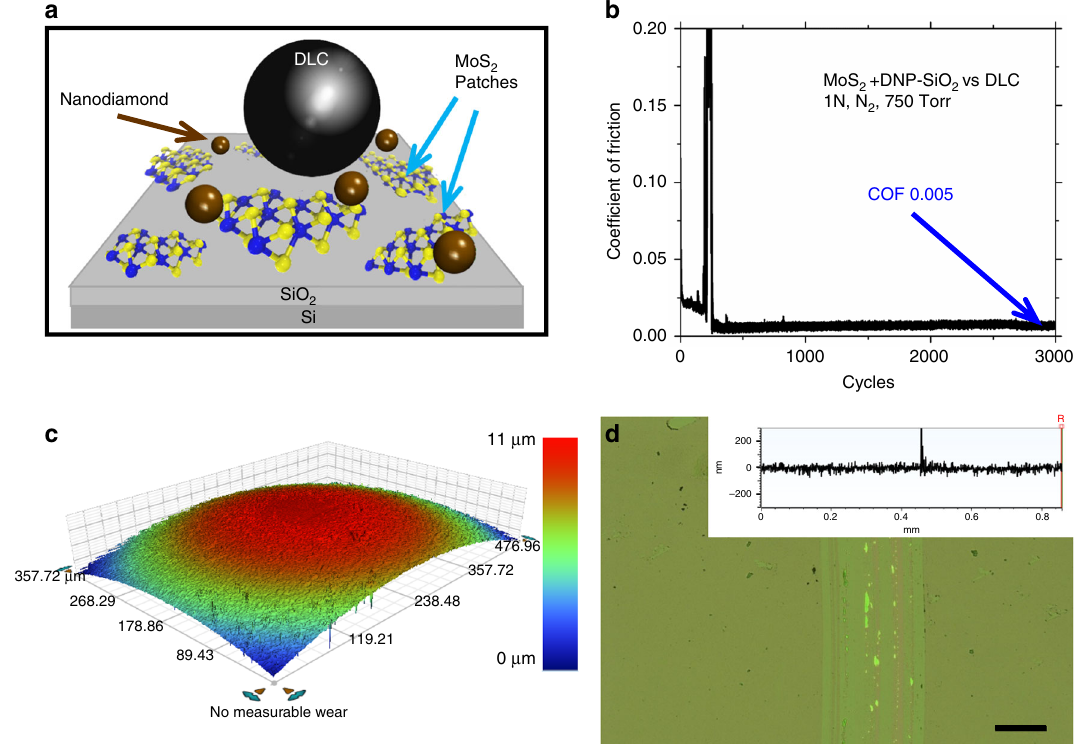
Fig. 1 Tribological performance of MoS 2 layers mixed with nanodiamond. a Schematic of the experimental setup, b graphs of the coef fi cient of friction, c wear of the ball, and d micrograph of fl at sides for MoS 2 mixed with nanodiamond and sliding against H-DLC surface. Negligible wear is indicated by line scan taken across the wear track (inset). The lowest coef fi cient of friction observed is 0.005 ± 0.002. The test was repeated fi ve times with the measurement uncertainty calculated based on the variations among the tests. The scale bar in Fig. 1d is 100 μ